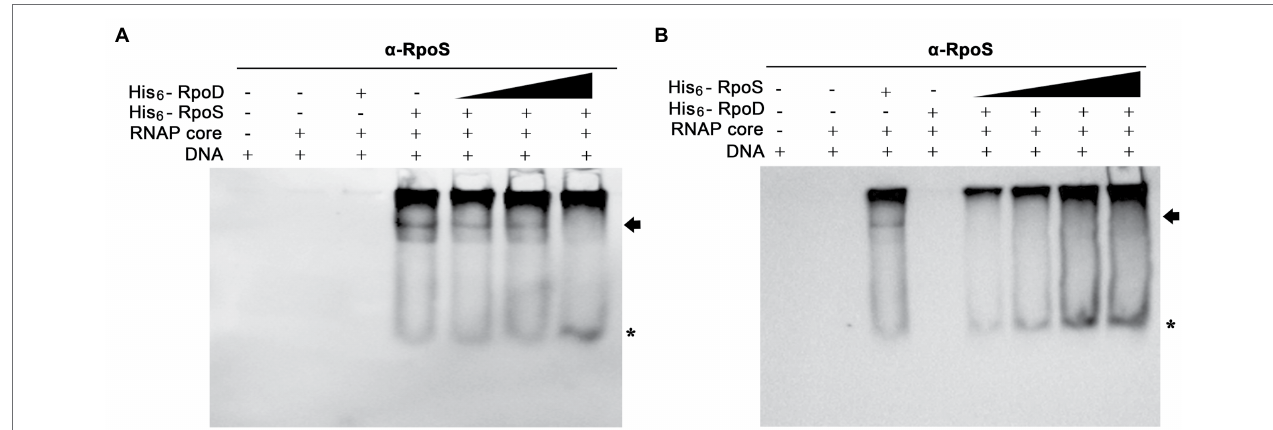
FIGURE 7 | Competitive binding to the P ssrA region between σ S and σ 70 in vitro . (A) Competitive EMSA was conducted with His 6 -RpoS at a constant concentration of 75 nM and with increasing concentrations (0, 12.5, 25, and 50 nM) of His 6 -RpoD as a competitor. RNAP core enzyme was pre-incubated with different combinations of two σ factors and incubated with DNA containing the P ssrA region. DNA bands were stained using EtBr and shown in Supplementary Figure 3A .